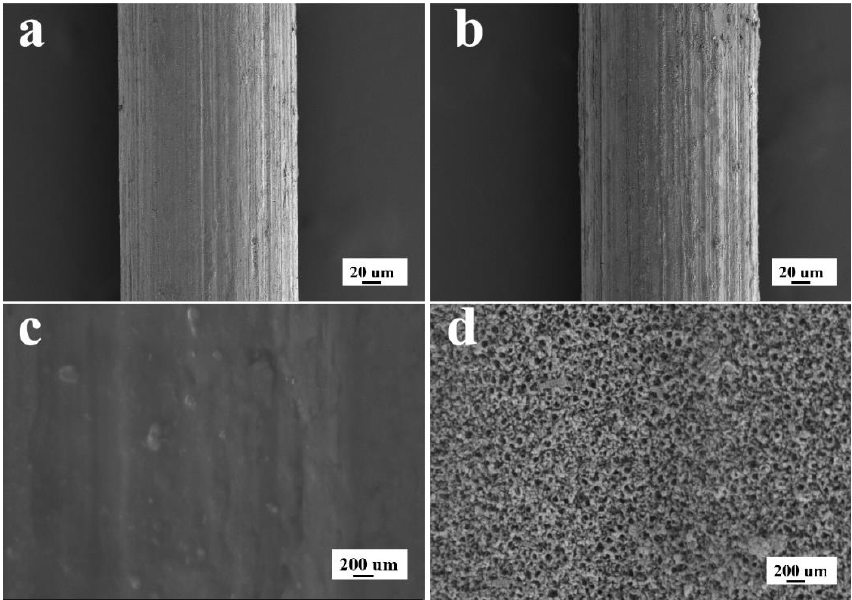
Figure 5. SEM images of the bare Ti wire ( a ) × 500, ( c ) × 50,000) and the Ti-TiO 2 NTs fiber ( b ) × 500, ( d ) × 50,000).